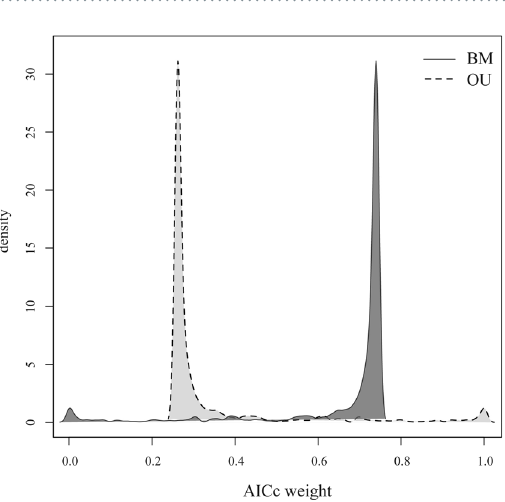
Figure 2. Density distribution of phylogenetic signal for Pagel’s lambda and Blomberg’s K metrics across 1000 Bayesian post burn-in phylograms for subgenus Agrodiaetus .